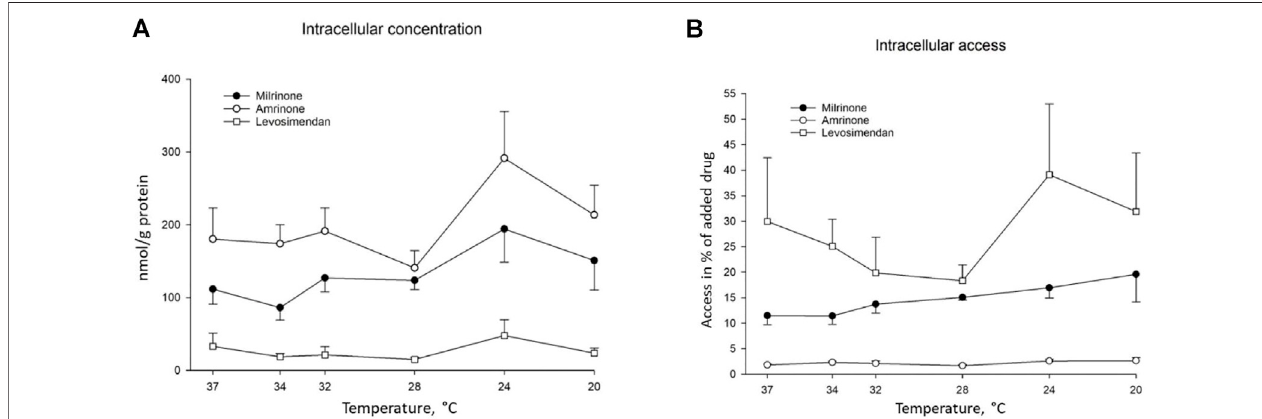
FIGURE 1 | Temperature-dependent intracellular access of added milrinone, amrinone, and levosimendan, presented as means ± SEM (A) Intracellular concentration of milrinone, amrinone, and levosimendan in nmol/g protein at temperatures ranging from 37 ° C to 20 ° C, n = 3. (B) Intracellular access of milrinone, amrinone, and levosimendan in % of drug concentration per gram protein, compared to drug concentration per gram protein in the incubation solution at temperatures ranging from 37 ° C to 20 ° C, n = 3.